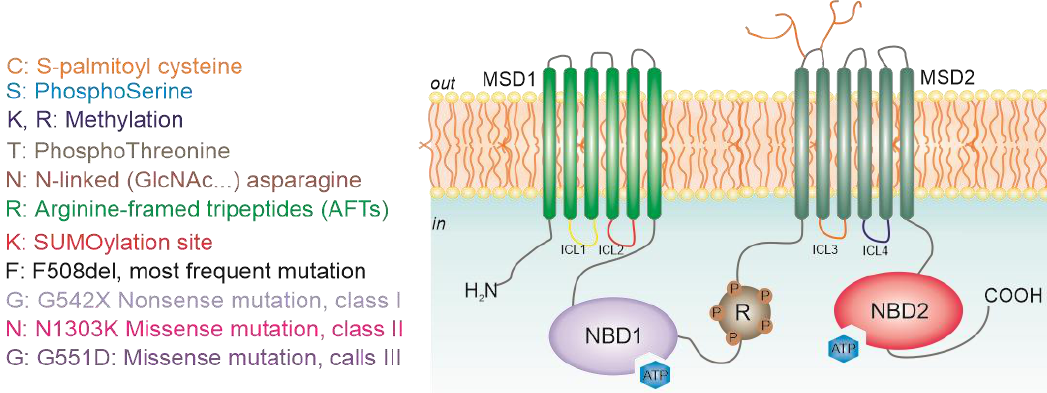
Figure 3. Representation of CFTR structure at the plasma membrane with known CFTR PTMs indicated in the primary sequence.